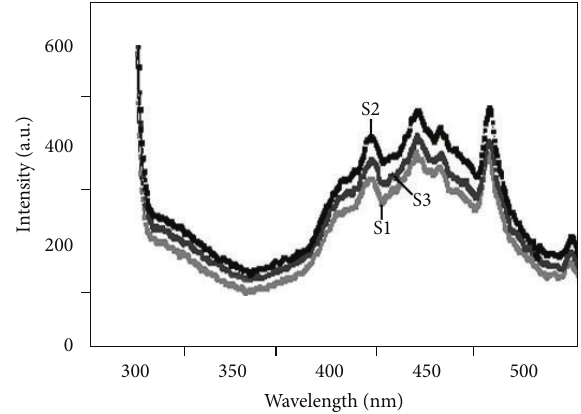
Figure 5: Room temperature PL spectra of MnWO 4